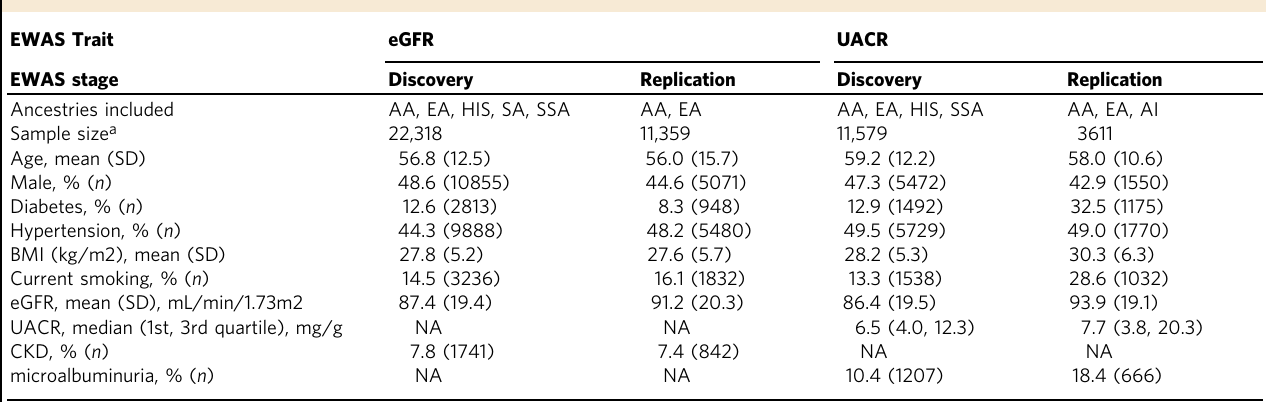
Table 1 Pooled characteristics of the discovery and replication